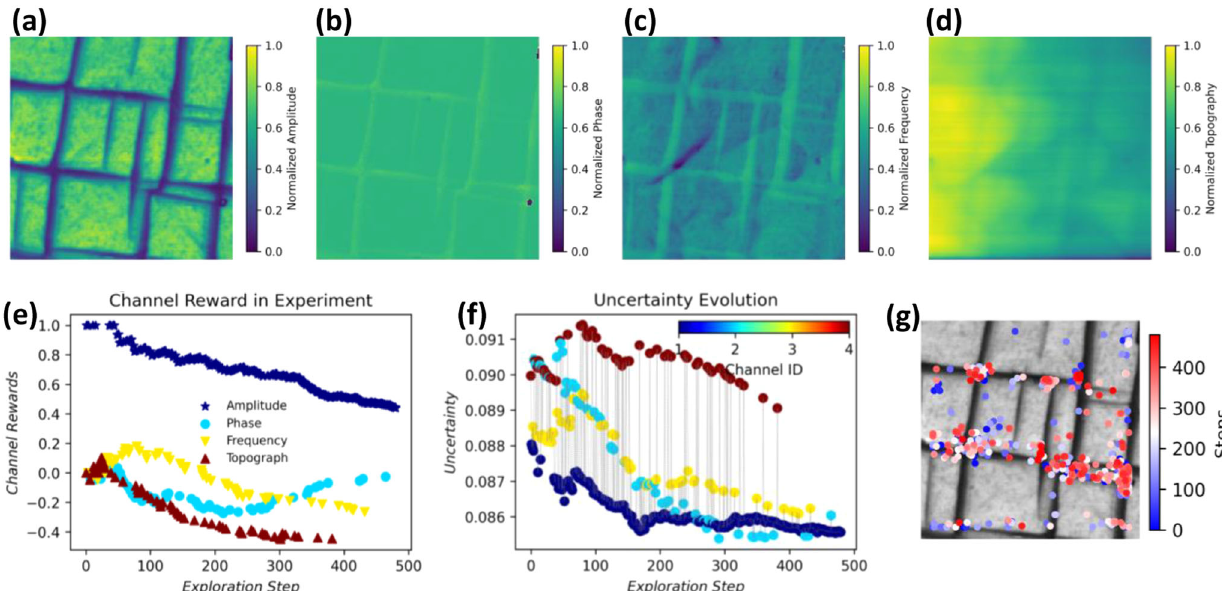
Fig. 6 Experimental process exploring structure-resonance frequency loop area relationship in PZT sample with a different exploration and exploitation balance. a – d BEPFM amplitude, phase, resonance frequency, and topography images. e Evolution of channel reward as a function of experiment steps. f The evolution of mean predictive uncertainty as a function of experimental reward. In this measurement, the ensemble DKL analysis starts with 0.4% of the data and use 20 warm-up states. After warm-up, the channel at each step is sampled with the epsilon-greedy policy and the epsilon decreased uniformly from 0.9 to 0.01 during the 480 steps. Here, the different epsilon as compared with previous measurements lead to a higher exploration chance (due to larger epsilon) at the beginning and higher exploitation chance (due to smaller epsilon) at the end of the measurement. g The measurement locations determined by DKL showing on amplitude map. Note that the measurement points are concentrated at the a-x domain boundaries, at which the polarization tilting can give rise to enhanced